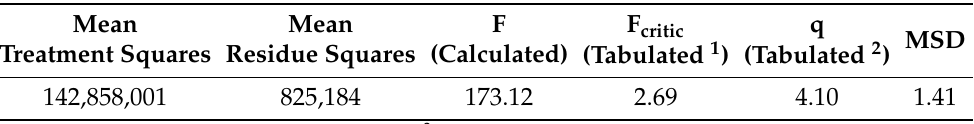
Table 7. ANOVA and Tukey test parameters for the Charpy impact tests.